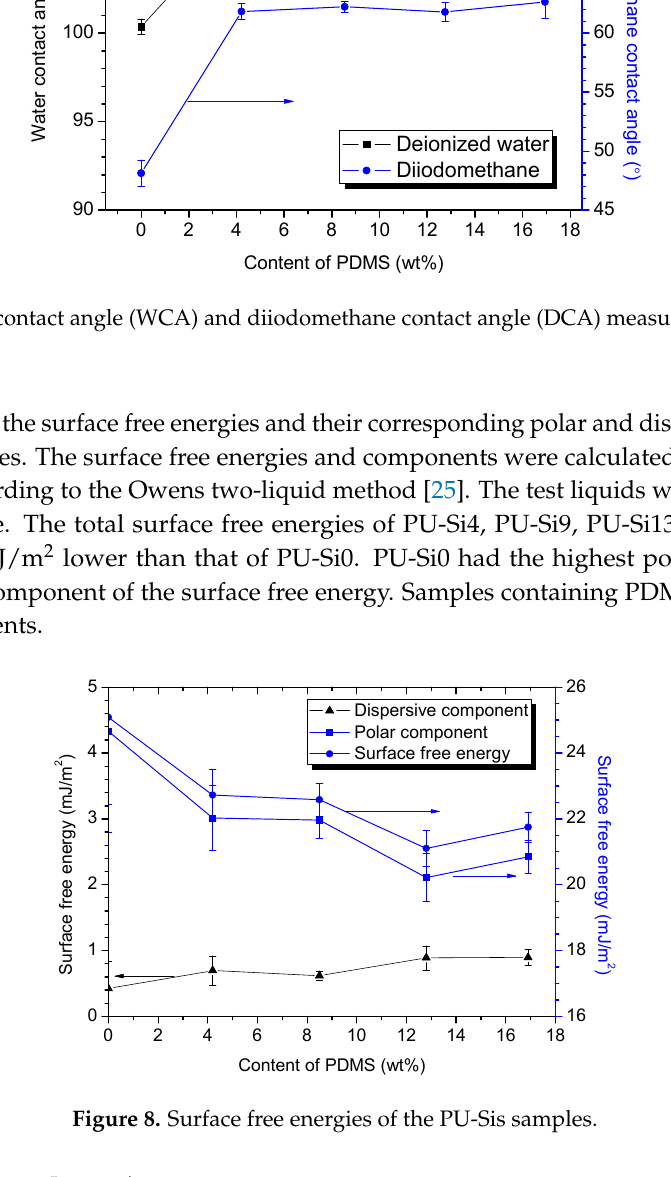
Figure 8. Surface free energies of the PU-Sis samples.